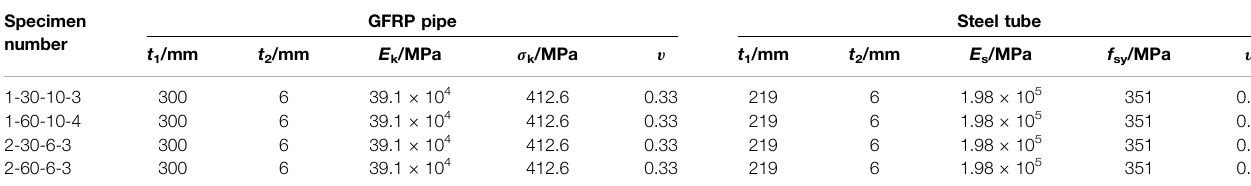
TABLE 4 | Speci fi c parameters of four specimens of GFRP pipe and steel tube. Specimen number